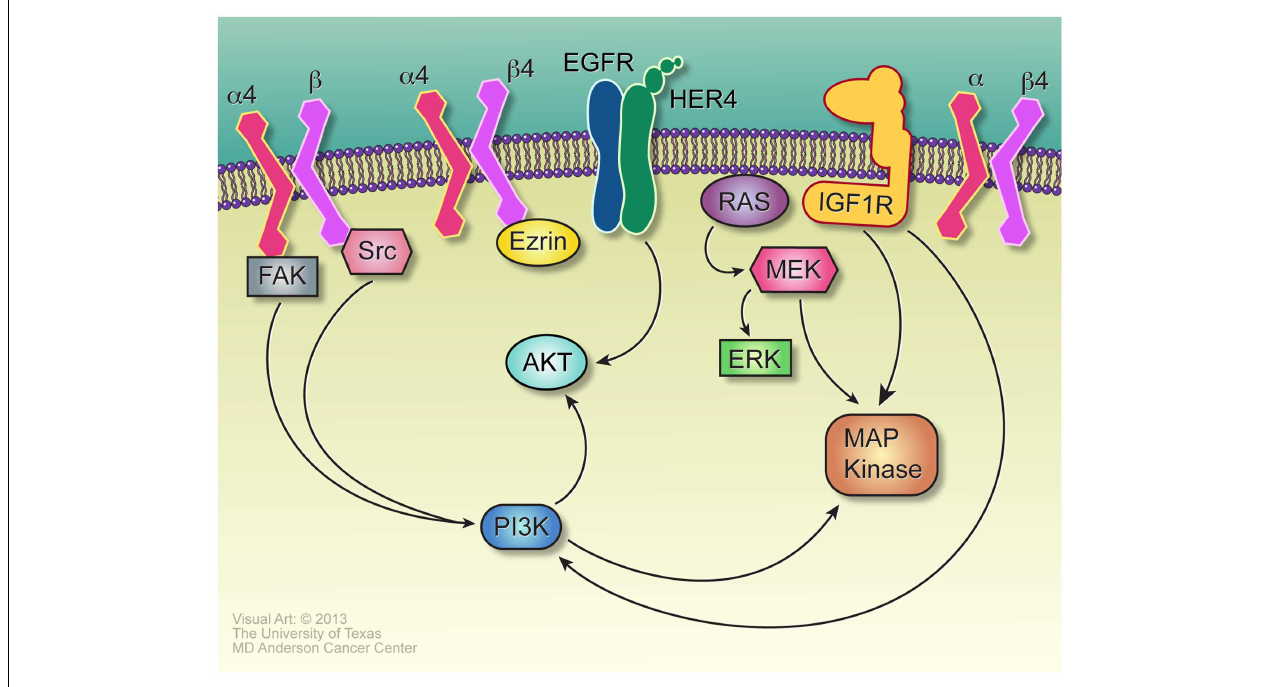
and mediates anoikis resistance, certainly for Ewing sarcoma and probably in osteosarcoma as well.While many receptor tyrosine kinases may mediate Ras activation and Ras-dependent and – independent activation of the MAP kinase cascade, IGF1R is an especially important source of these signals, especially for anoikis resistance in Ewing